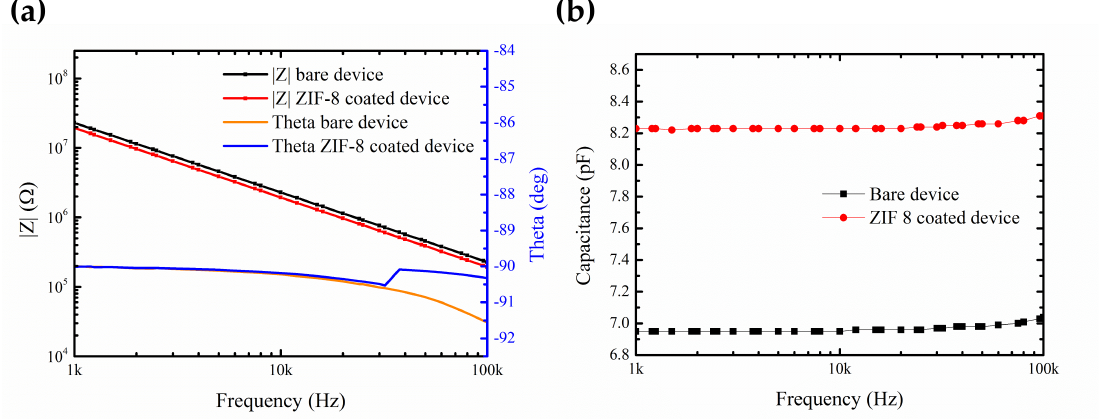
Figure 6. ( a ) Impedance and Theta versus frequency. ( b ) Comparison between capacitance of bare and ZIF-8 coated device versus